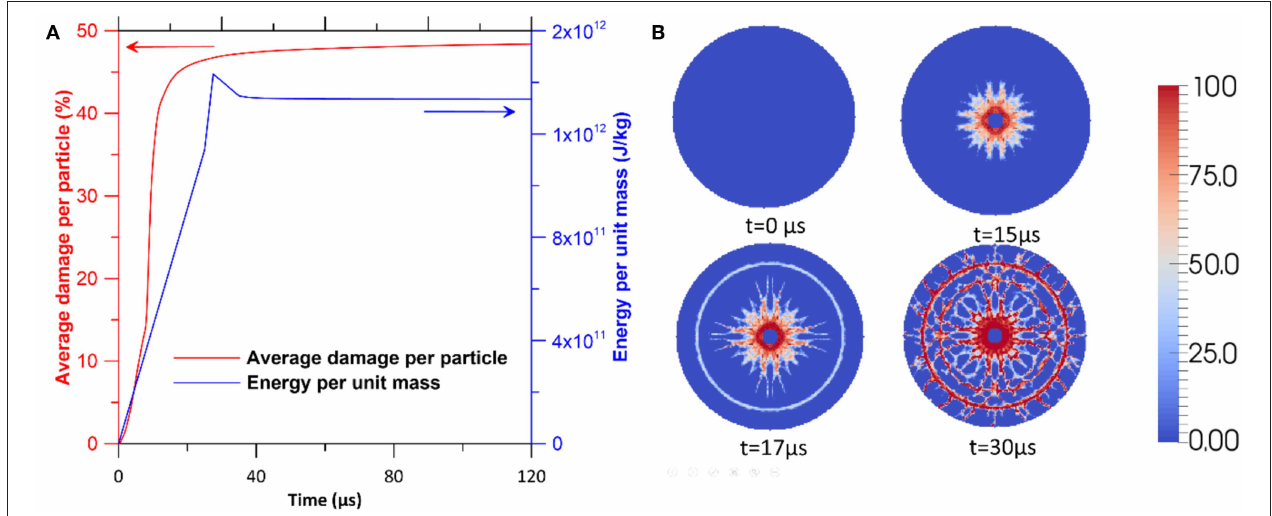
FIGURE 3 | (A) Average damage per particle (left axis, red) and total mechanical energy (right axis, blue) of the glass plate, subjected to an impact by a copper bullet, with respect to time. Note that the results correspond to that of a glass plate with a radius of 37mm, thickness of 0.0025m, elastic modulus of 94.5 GPa, and fracture energy of 4.3 J/m 2 . (B) Damage map in the glass plate subjected to impact at four different times, namely, 0, 15, 17, and 30 0 µ s. The coloring scale, representing the local damage, varies from 0% (blue) to 100% (red).